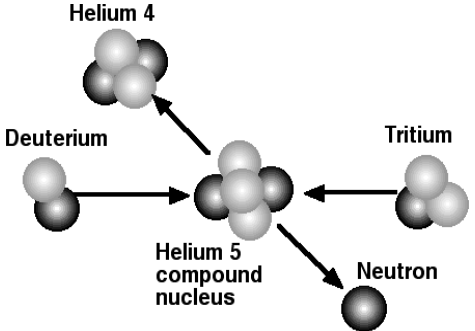
Figure 1. Schematic diagram of the DT fusion reaction via a compound nucleus. Encounter of deuterium and tritium produces 5 He compound nucleus and emits a 3.52 MeV 4 He and a 14.06 MeV